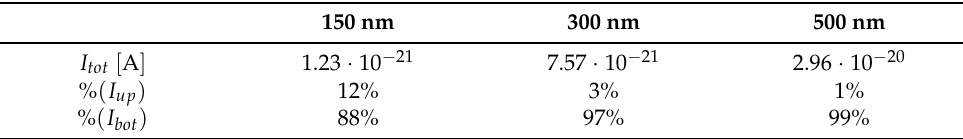
Table 1. O − current exiting the nanoparticle from the upper ( I up ) or bottom half ( I bot ) and relative 2 percentage as a function of the radius of the